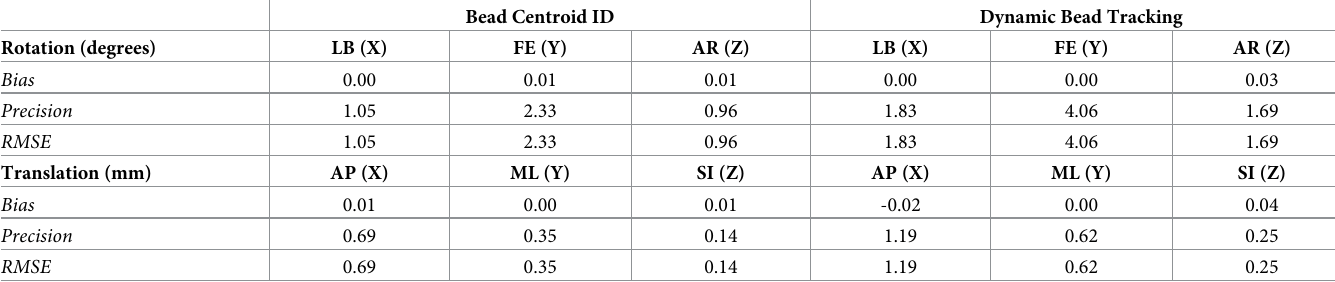
Table 4. Monte Carlo simulation